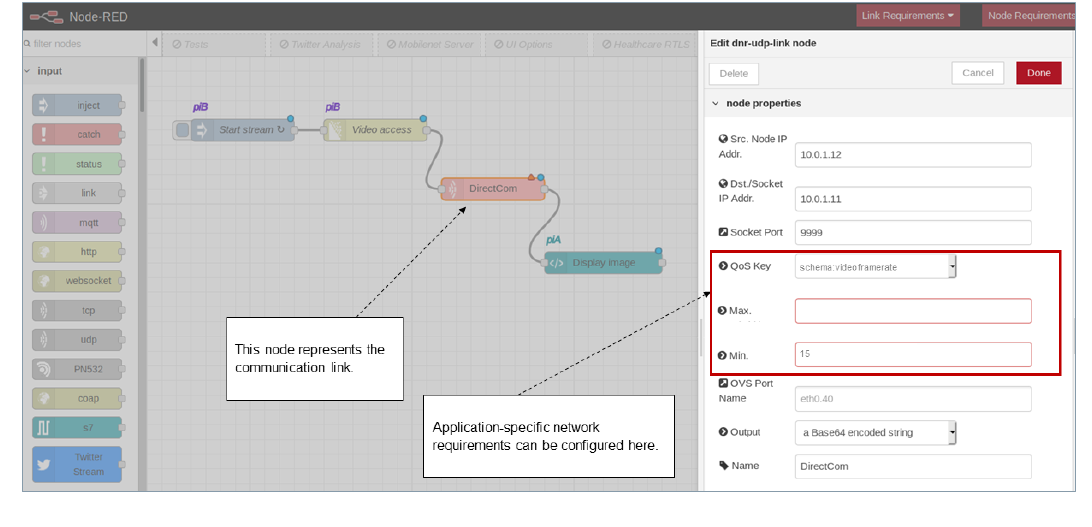
Figure 3. Extended Distributed Node-RED (DNR) to allow the specification of quality of service (QoS) constraints from application perspective.